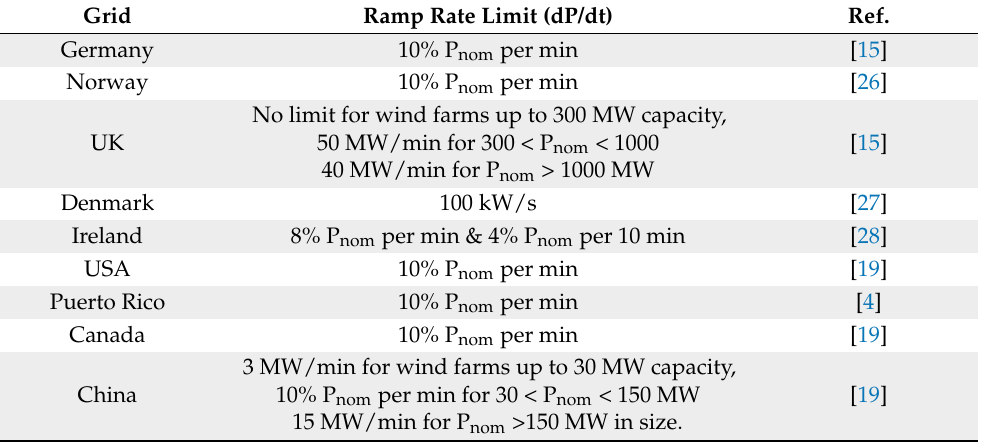
Table 1. Ramp rate limits for some relevant countries in the world.